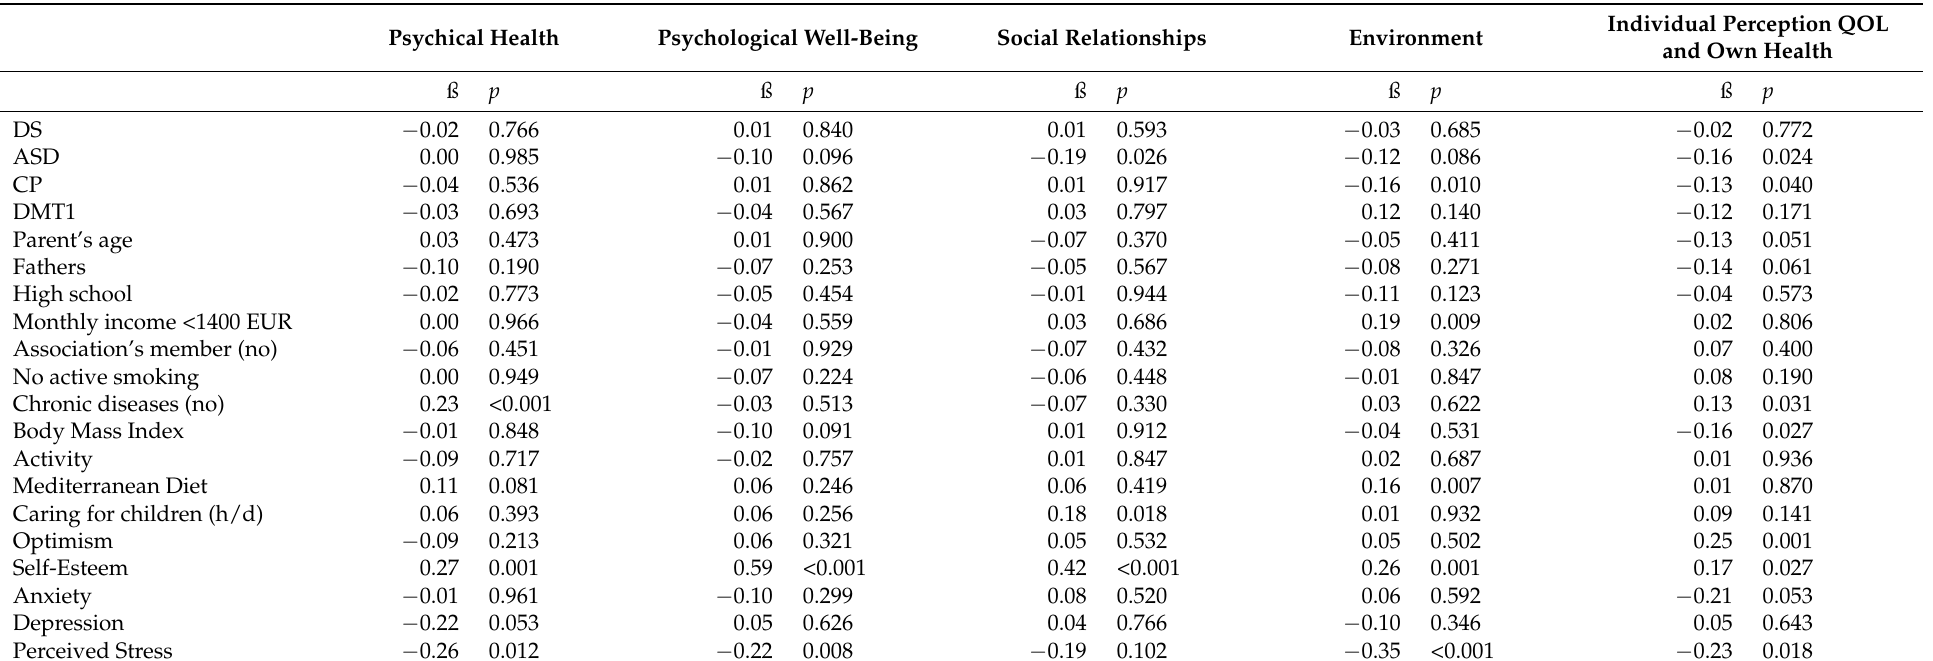
Individual Perception